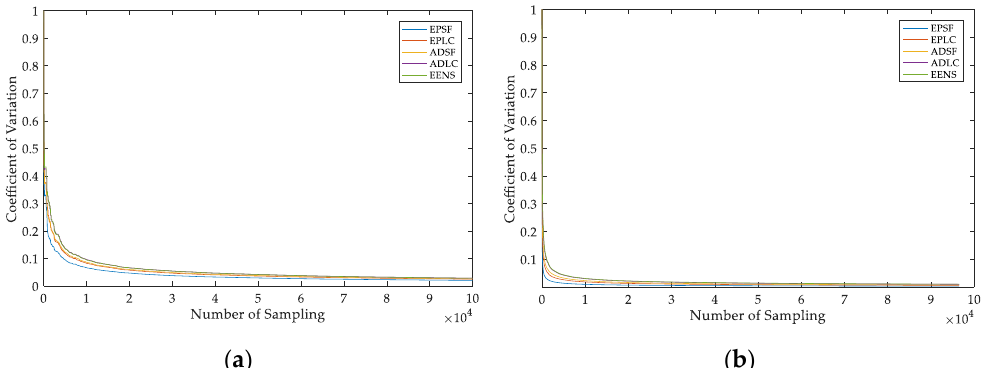
Figure 10. 100,000 sampling coefficient of variance. ( a ) Coefficient of variance of simulation method; ( b ) coefficient of variance of hybrid method.